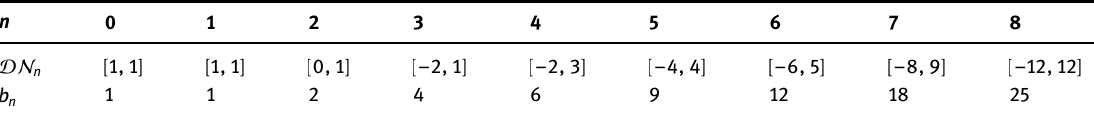
Table 2: The fi rst few values of (cid:4)(cid:3) n and b n up to = n 8 n 0